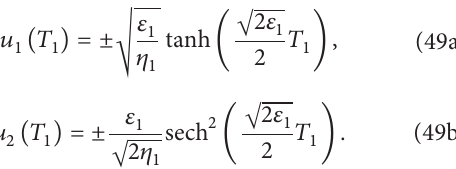
Set 𝜀 = 0 ; then (47a) and (47b) are a system with the Hamiltonian